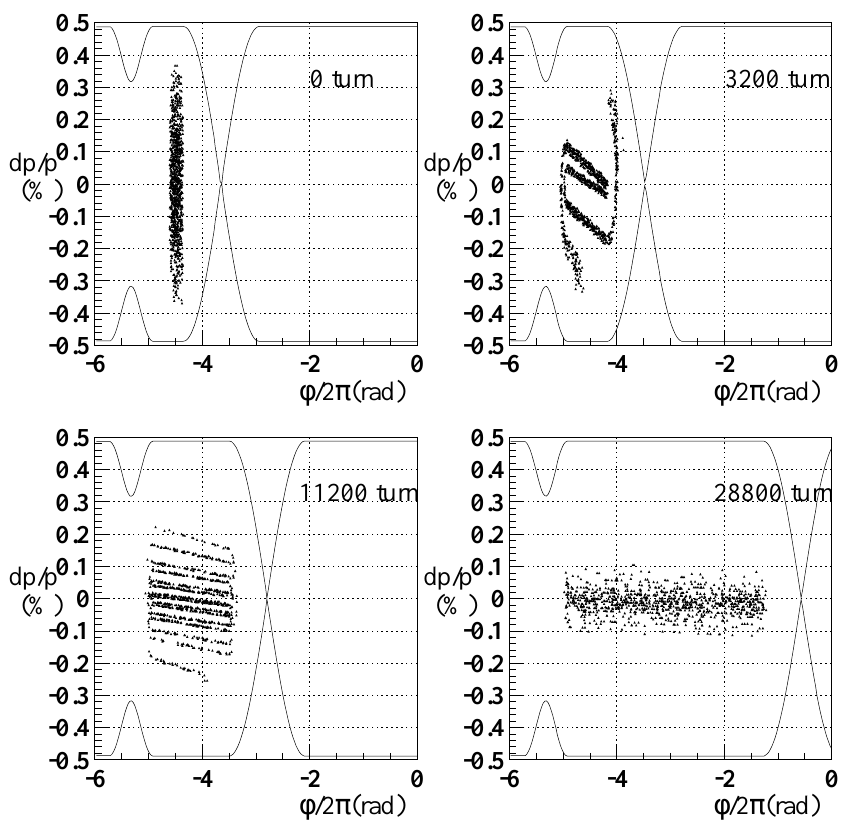
FIG. 12. Phase-space configurations during the first adiabatic debunching. The solid lines are the separatrix. The horizontal and vertical coordinates are the rf phase and momentum spread, respectively. A phase of 12 p corresponds to one revolution.